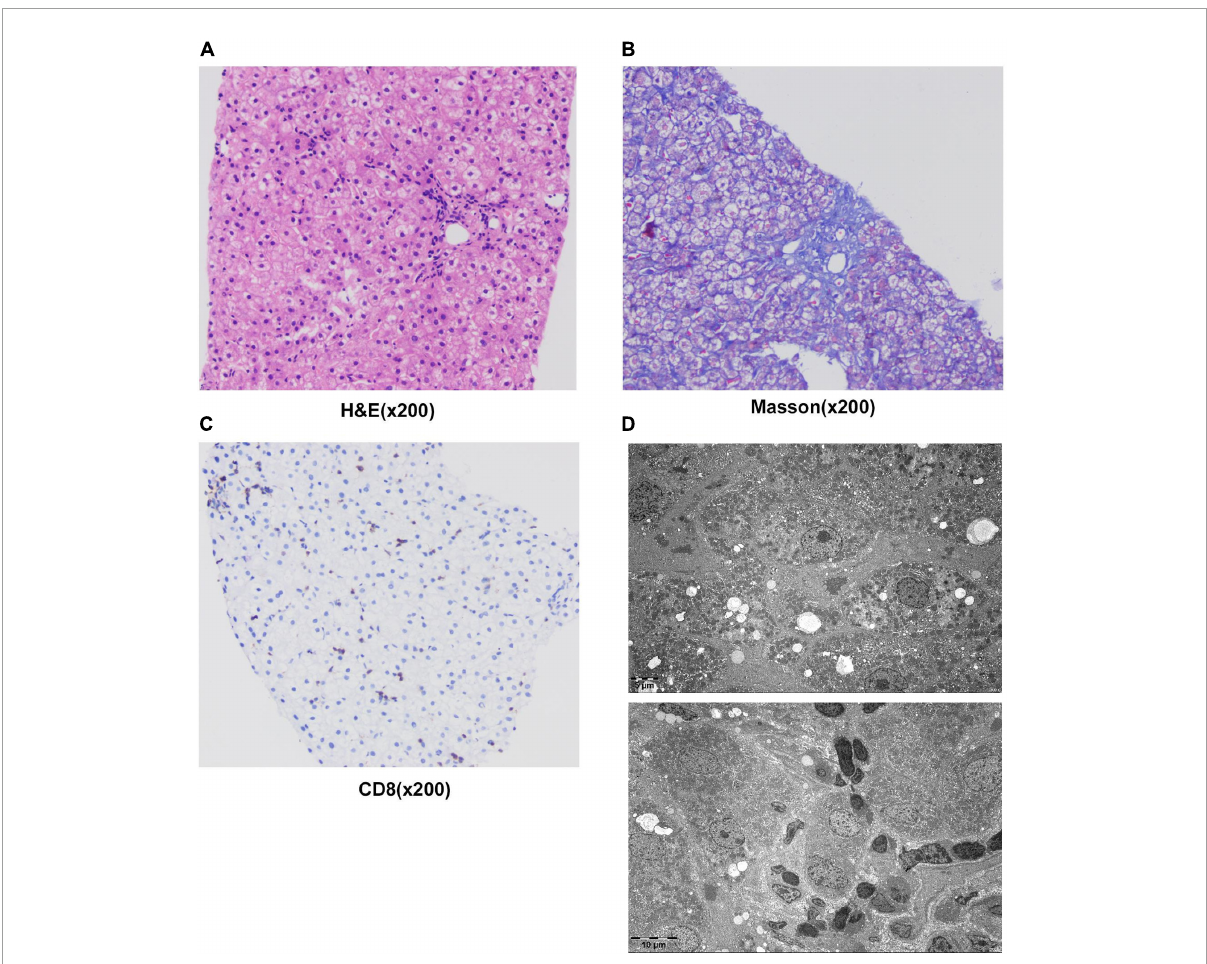
FIGURE2 Results of liver histology of the patient. (A–C) Liver biopsy results. H&E staining of liver tissue showed swollen hepatocytes and inflammatory cells infiltrating into portal duct areas, and there was mild interfacial inflammation (A) . Masson staining indicated mild hepatic fibrosis in the portal area (B) . Immunohistochemical staining of CD8 + T-lymphocytes (C) . (D) The result of electron microscopy showed chronic active hepatitis. No viral inclusions were